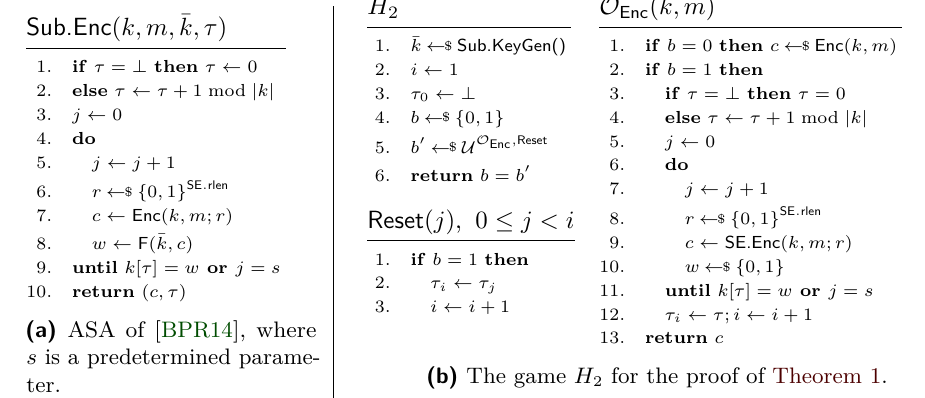
Figure 5: ASA on symmetric encryption by Bellare, Paterson, and Rogaway [BPR14] and game for proof of its undetectability in Theorem